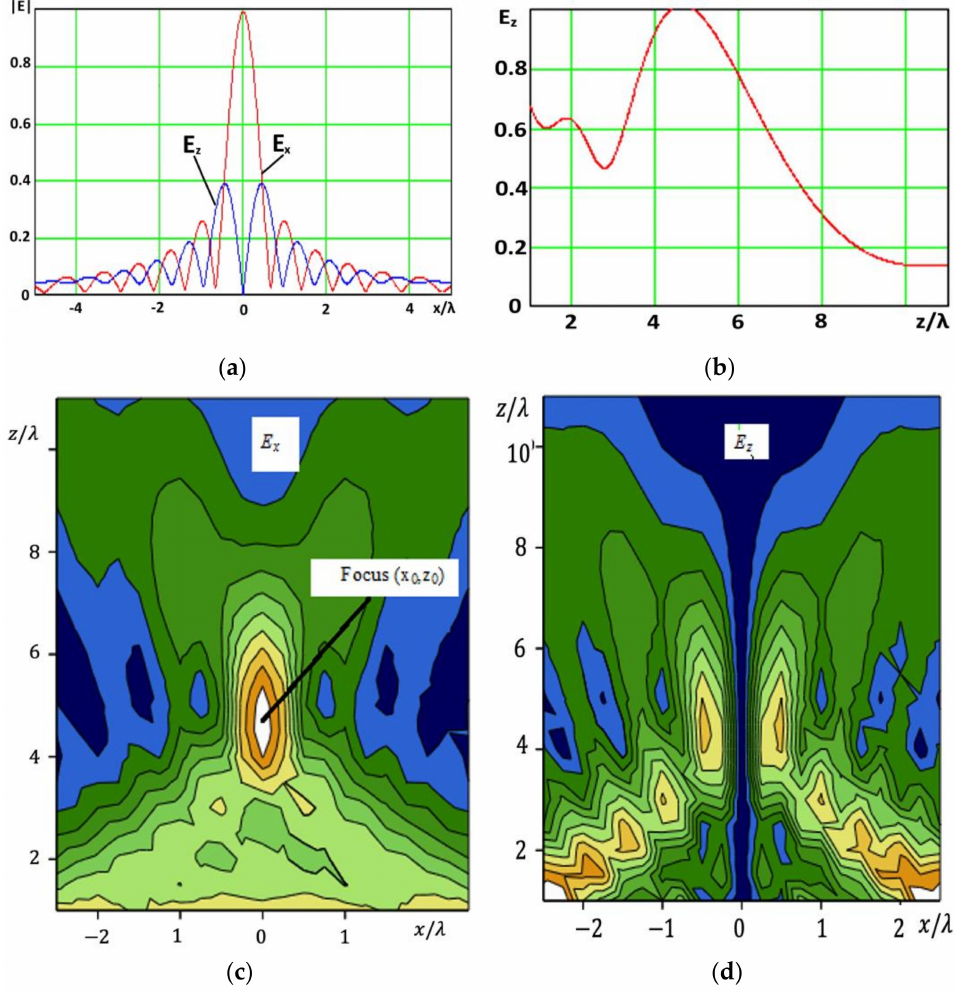
Figure 3. Spatial distributions of electric field intensity: ( a ) dependence of the horizontal and vertical components in the focal plane; ( b ) dependence in the transverse direction; ( c , d ) spatial dependences of the E x and E z